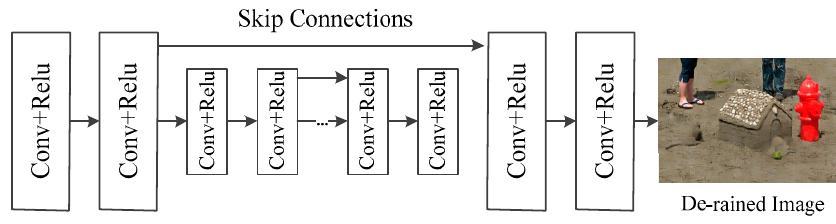
Figure 4. Architecture of the generative network.